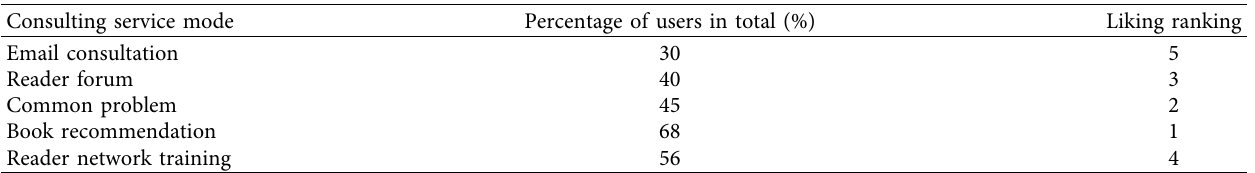
Figure 9: Opening of interactive information service projects at home and abroad. Table 2: Users’ attitudes towards specific consulting services.